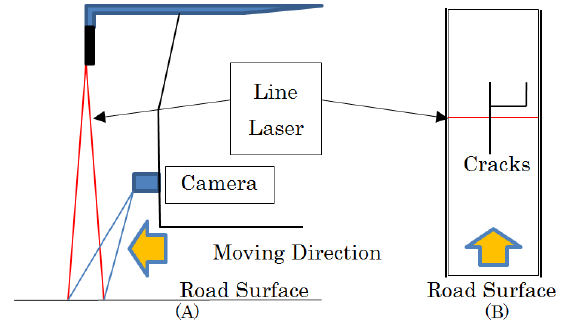
Figure 1. 3D laser scanner vehicle